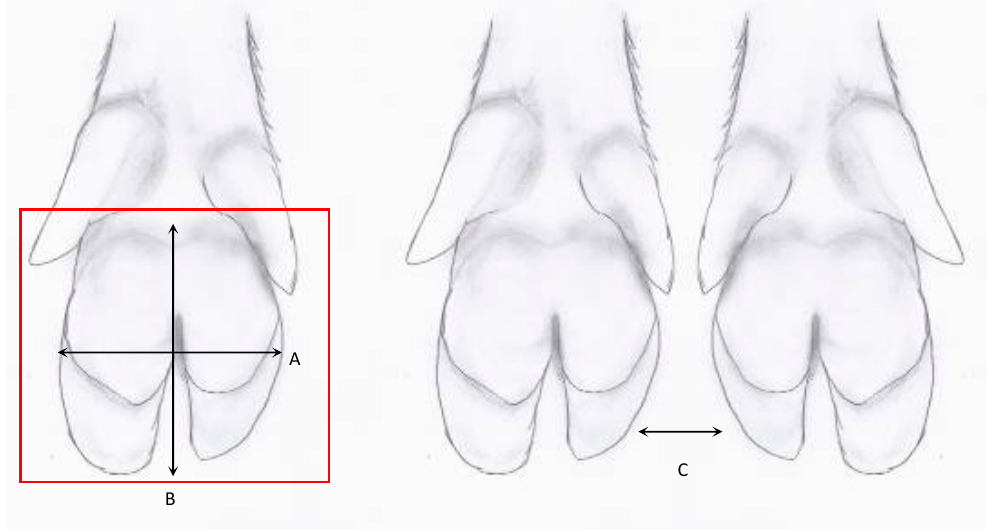
Figure 4. Claw anatomy of pigs to calculate the surface area that must be covered by the cameras for a complete view of the claw. The red coloured square represents the area of the claw which is often in contact with the underlying surface when standing and moving. A = the claw width varying between 65 and 80 mm, and B = claw length varying between 95 and 130 mm. Based on these claw measurements, the calculated surface area is 130 mm × 80 mm (i.e., 10,400 mm 2 ). C = the maximum distance between the cameras, which was determined by measuring the distance between the left and right claw, which was 230 mm, range was 70 to 230 mm.